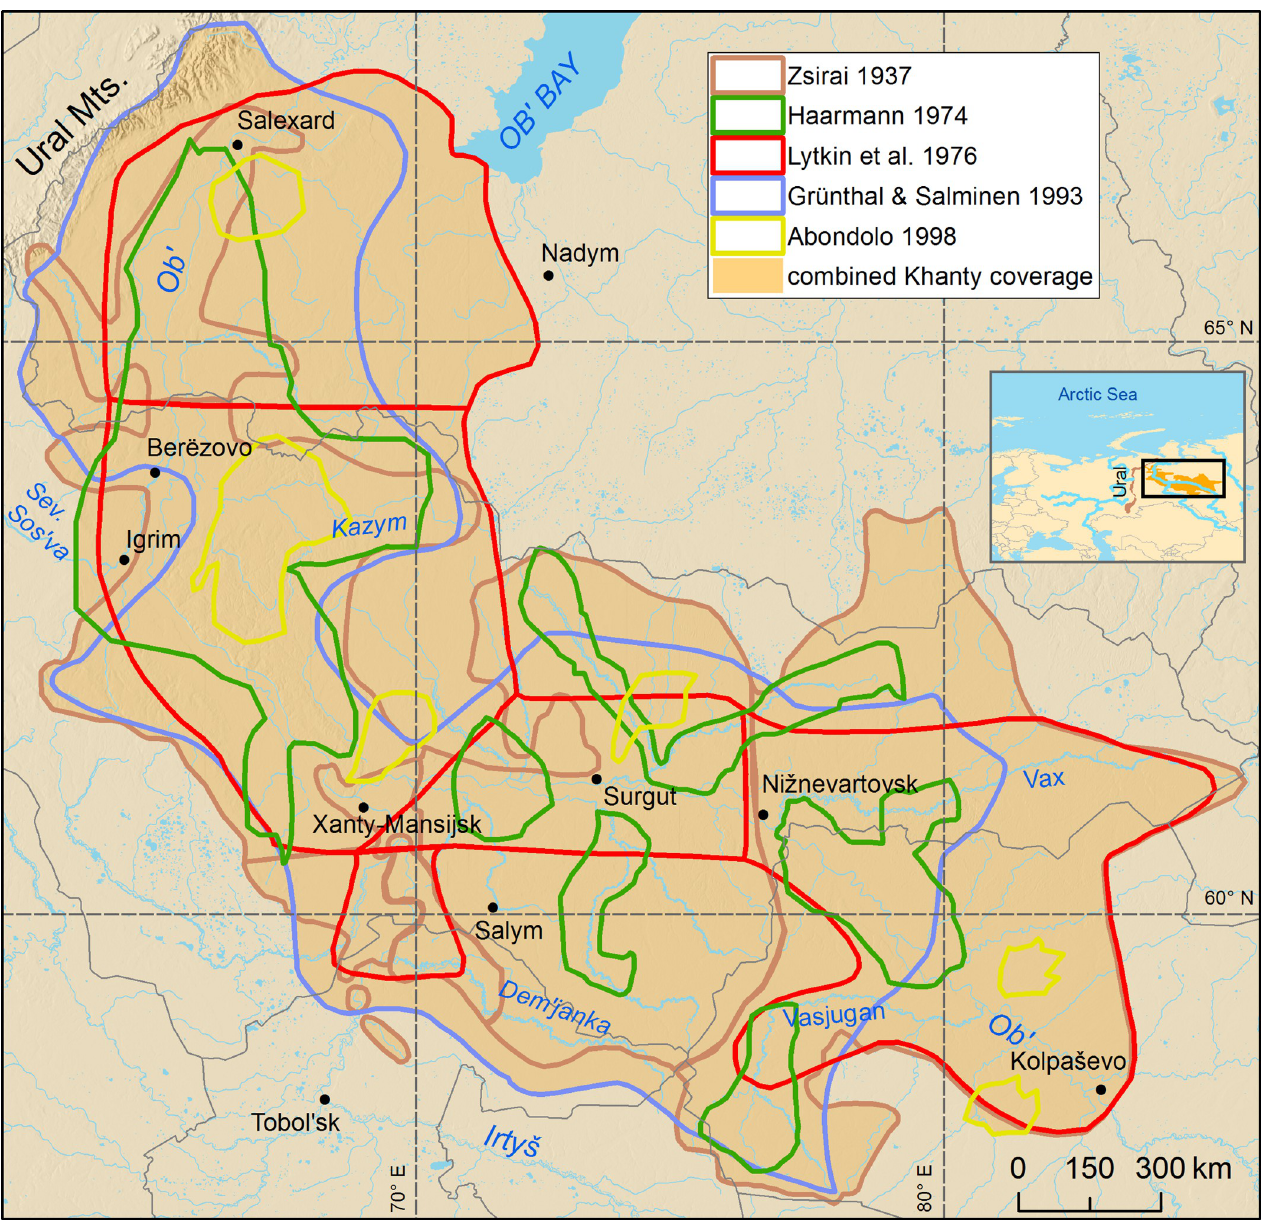
Fig 1. Geographical overlap of different source materials concerning the distribution of the Khanty language(s) at the beginning of the 20th century. Original sources Zsirai [34], Haarmann [41], Lytkin et al. [35], Gru¨nthal & Salminen [33] and Abondolo [42] have been visualized using boundaries of each polygon. A solid green area has been created merging the distributions of all Khanty sources, and it is indicating the area where Khanty could have been spoken. Basemap datasets from Natural Earth [43], Digital Chart of the World [44] and ESRI